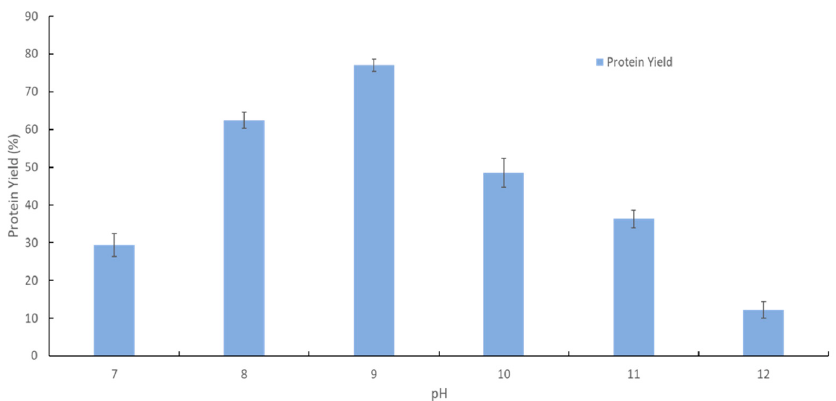
Figure 3. Effect of pH on immobilization.